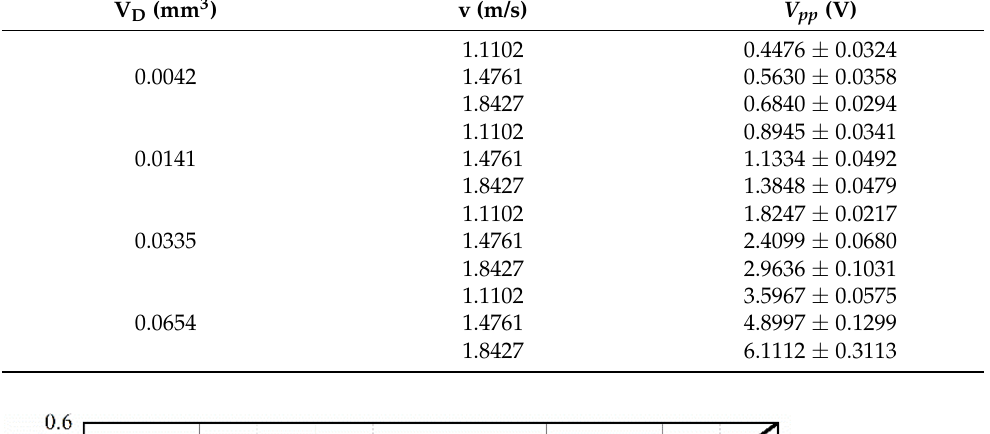
Table 4. Experimental data.